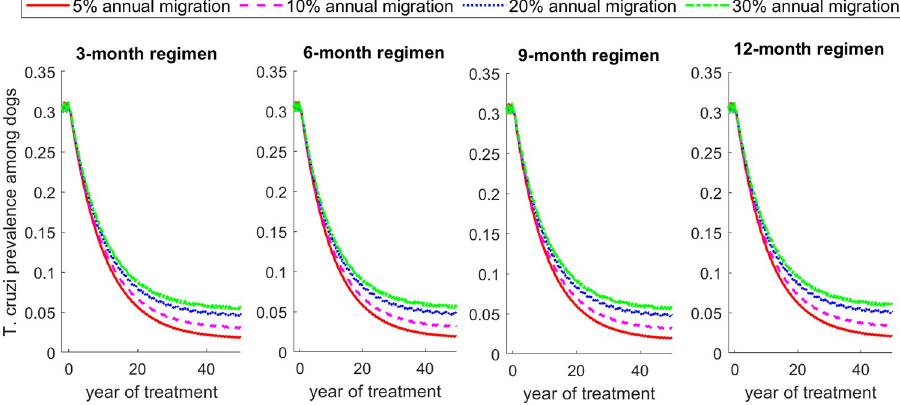
Fig 9. Impact of triatomine migration rate between sylvatic and peridomestic communities on the effectiveness of fluralaner treatment regimens for reducing dog T . cruzi prevalence.